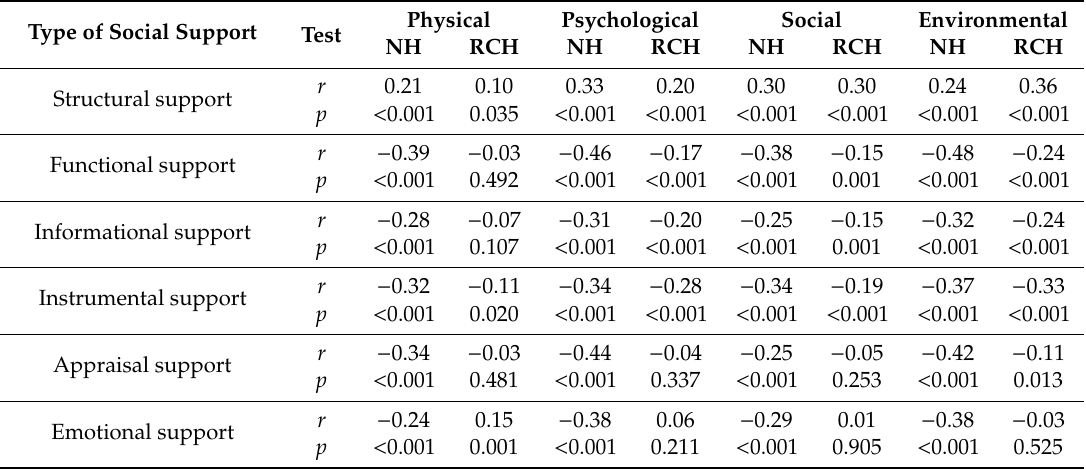
r —Pearson correlation coe ffi cient, p —statistical significance.